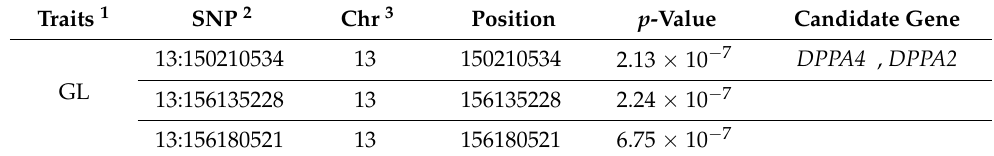
Table 4. The significant SNPs in the genome for the gestation length (GL) trait using chip data in pigs. Traits 1 SNP 2 p